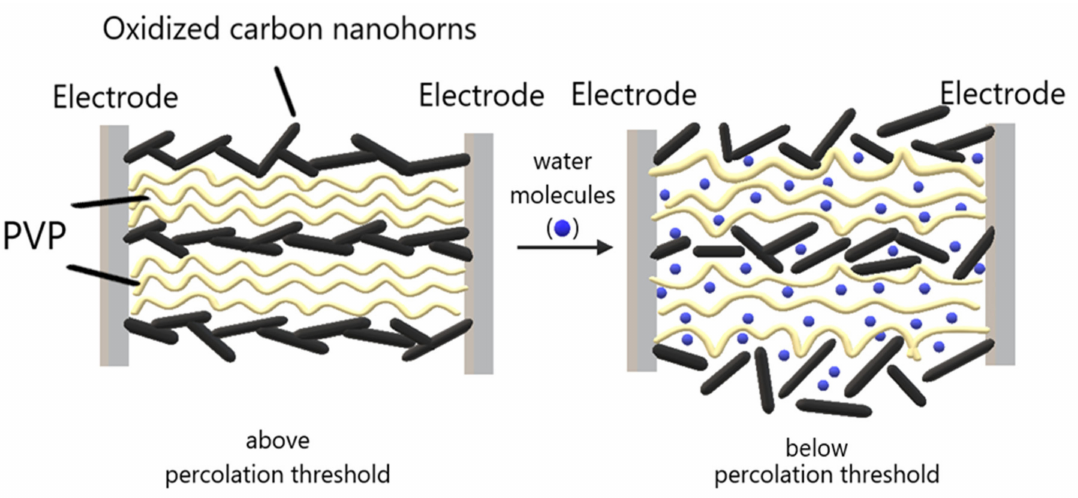
Figure 9. Swelling of hydrophilic CNHox–PVP nanohybrid around the electrical percolation